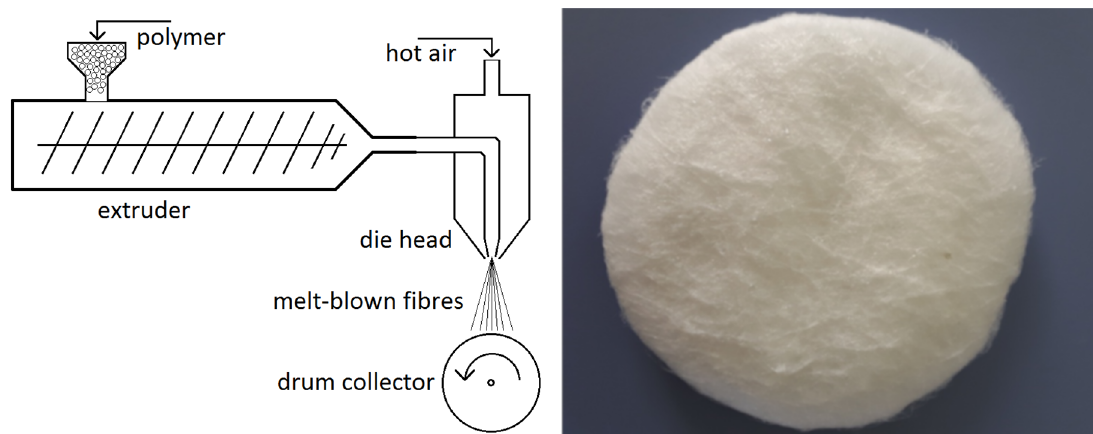
Figure 2. Melt-blown method overview ( left ) and obtained filter sample ( right ).